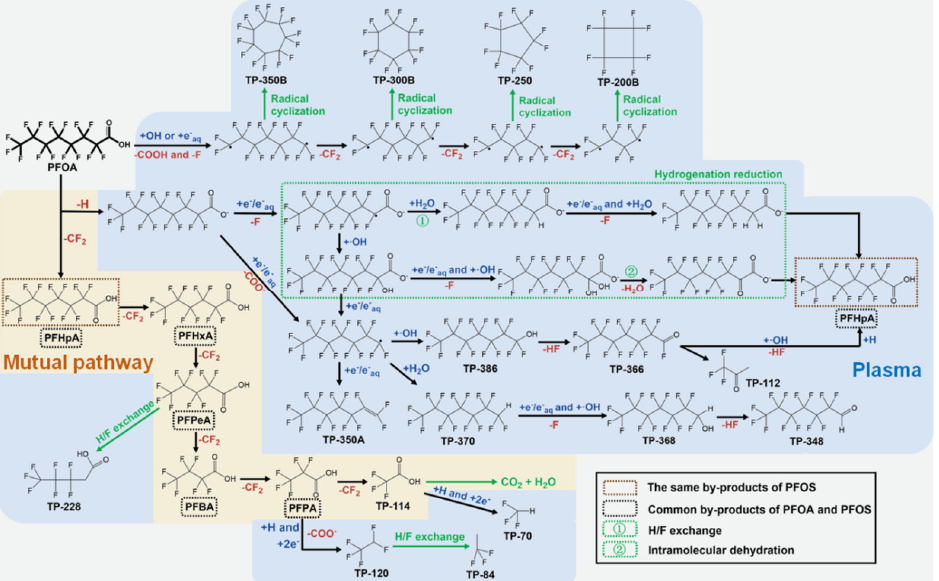
Figure 3 . Transformation pathways and reaction mechanisms of PFOA during the treatments using electron beam and plasma irradiation. Note: Blue area: the pathway of PFOA during the plasma irradiation; orange area: the pathway of PFOA during both electron beam and plasma irradiation.